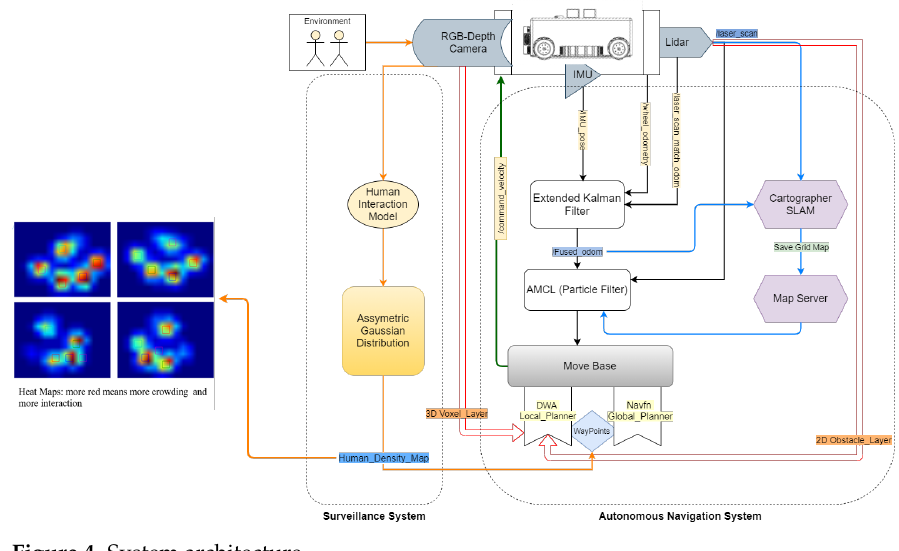
Figure 4. System architecture.